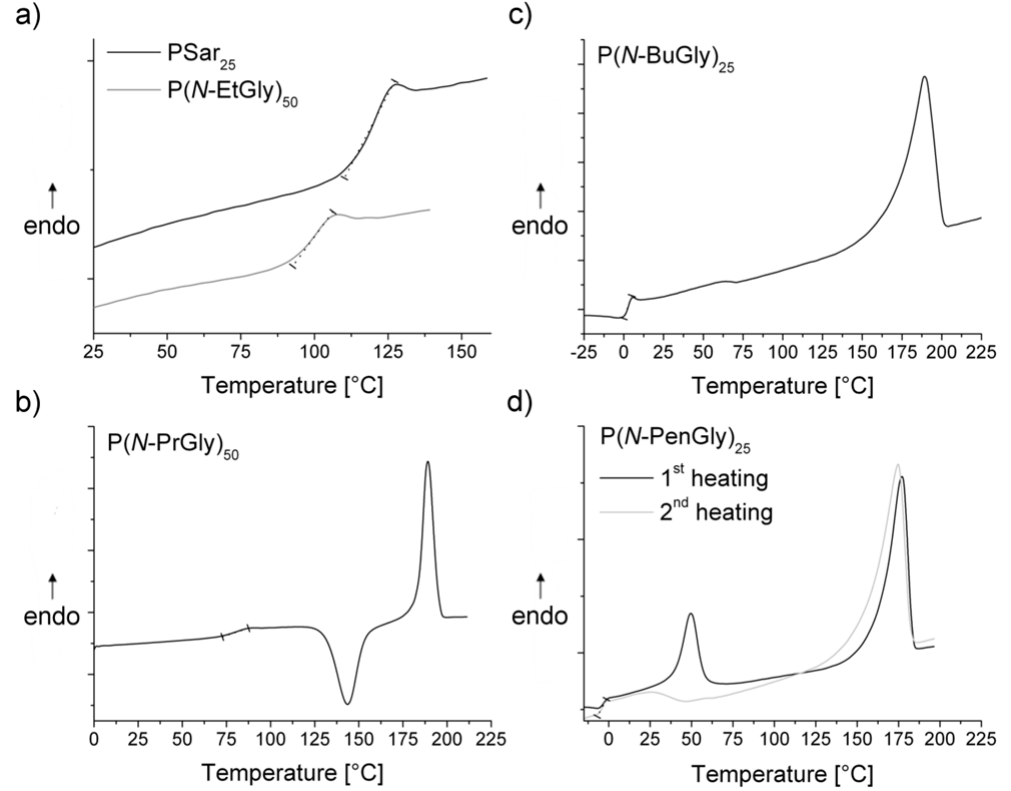
Figure 5. ( a ), ( b ), ( c ) Second heating DSC thermograms of some synthesized polypeptoids and ( d ) comparison of the first and second heating DSC thermogram of P( N -PenGly) ( P18 ). Glass transition temperature ranges were marked with a dotted line in each